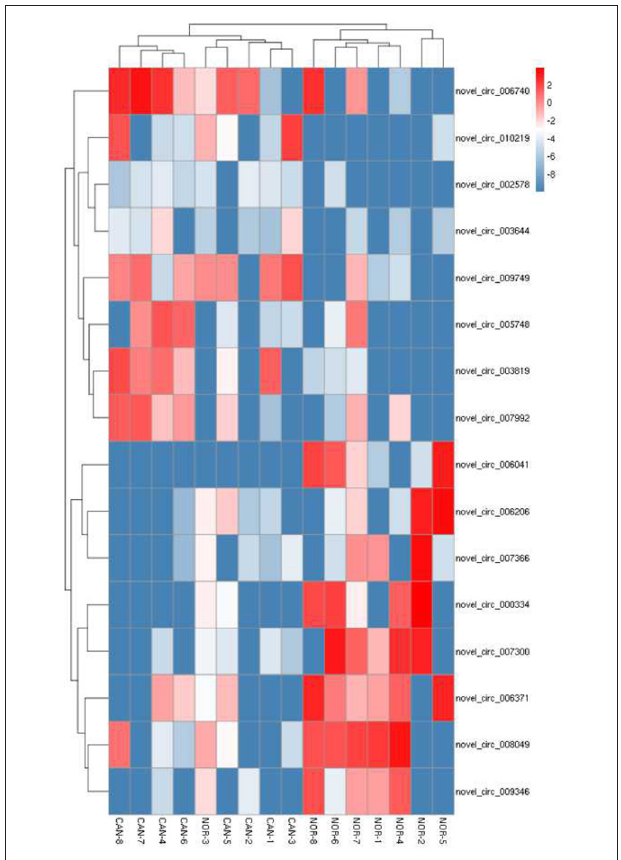
FIGURE 6 | Heat map and hierarchical clustering showing expression values of the most up and down regulated circRNAs.